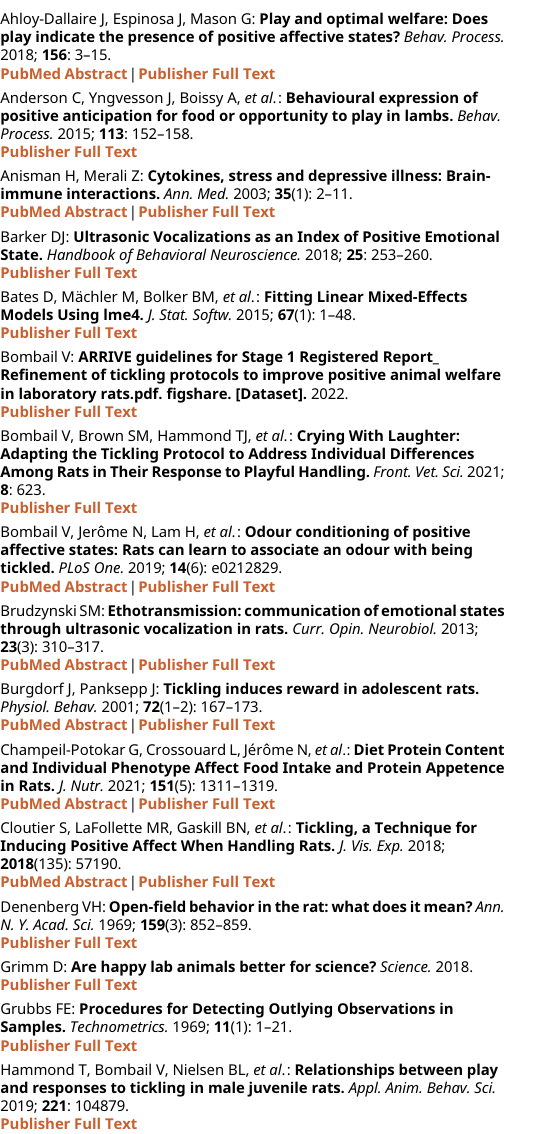
Figshare: ARRIVE guidelines for ‘ Stage 1 Registered Report: Refinement of tickling protocols to improve positive animal welfare in laboratory rats ’ . https://doi.org/10.6084/m9.figshare.20914993 (Bombail, 2022). Data are available under the terms of the Creative Commons Zero “ No rights reserved ” data waiver (CC0 1.0 Public domain